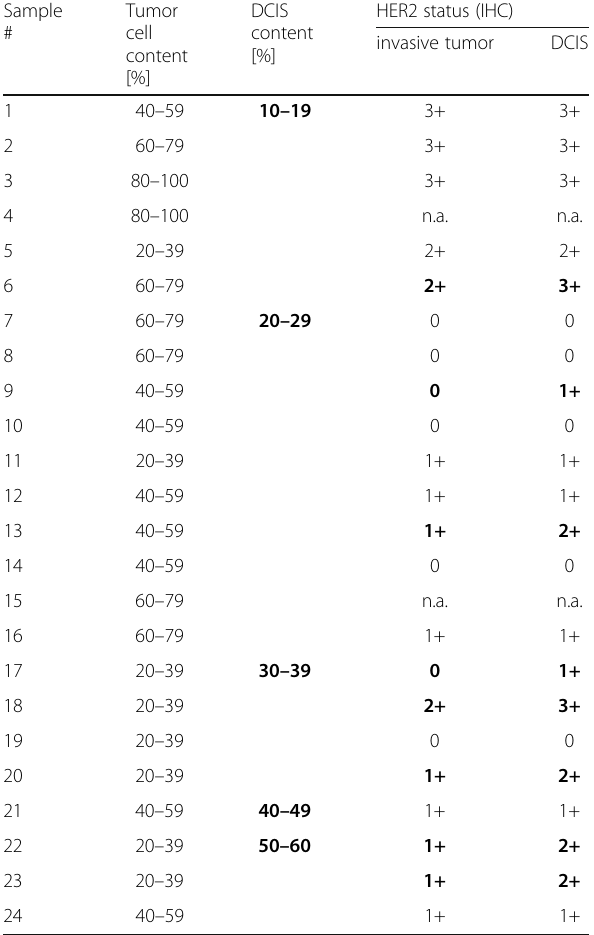
Table 2 Characteristics of tissue samples used for the analysis of DCIS on relative gene